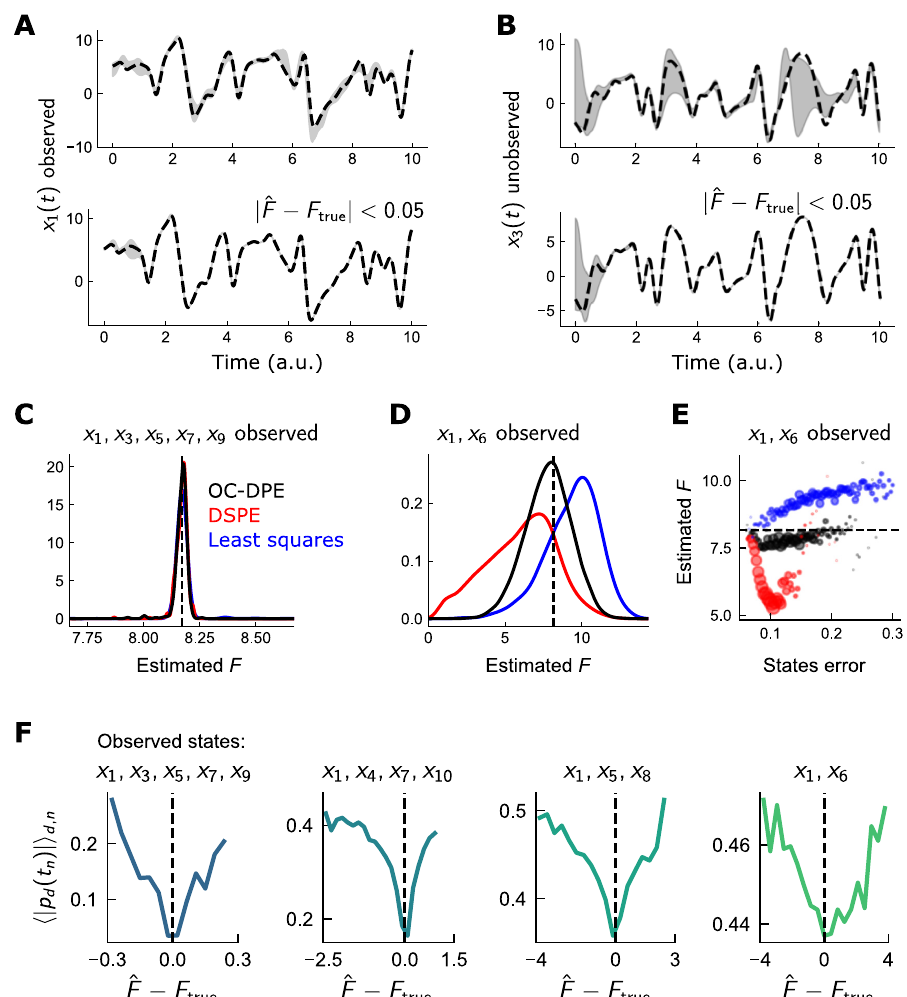
Fig 3. OC-DSPE exhibits enhanced parameter estimation accuracy in sparsely-observed chaotic models. Illustration of parameter estimation in chaotic Lorenz96 system using optimally-controlled dynamical state and parameter estimation (OC-DSPE). A: Illustrative estimate of observed variable x 1 ( t ) when 4 states are observed, for 100 estimations randomly initialized (top), and for only those estimations in which the parameter was estimated to high accuracy (bottom; j ^ F (cid:0) F j < 0 : 05 ). Grey: standard deviation of all estimates; Dotted: true state. B: Same as A, for the unobserved variable x 3 ( t ). C: Histogram of parameter estimates over 100 initializations, for 100 datasets initialized throughout the 10D Lorenz96 chaotic attractor, for 5 observed variables and using 3 different estimation routines (least squares, the original DSPE algorithm, and OC-DSPE). Parameter estimates are tightly clustered around the true value of 8.17. D: Same as C, for only 2 observed variables. Estimated ^ F is more widely dispersed, but centered on the true value only for OC-DSPE. E: Estimated parameter ^ F versus error in observed states x averaged over space and time. For low state error, estimated parameters are close to the true value for all 3 estimation routines. Tor larger state errors, proximity to the true value occurs only in OC-DSPE, indicating a larger degree of robustness in estimation accuracy. F: Dependence of | p ( t )|, averaged over dimension i and time n , on error in parameter estimate, ^ F (cid:0) F , for 5 (leftmost d n plot), 4, 3, and 2 (rightmost plot) observed states. In all cases, the minimum average | p | occurs at very close to the true F , indicating that the values of the conjugate momenta can act as a proxy for identifying the optimal parameter estimate. controlled dynamics, suggesting a lack of estimation accuracy (Fig 3E). Do deviations in p also have some bearing on the reliability in the parameter estimate? In other words, is there a corre- lation between some statistic of p and the estimation errors in F ? Indeed, plotting the magni- tude of p averaged over time and dimension as a function of ^ F (cid:0) F shows a prominent dip true